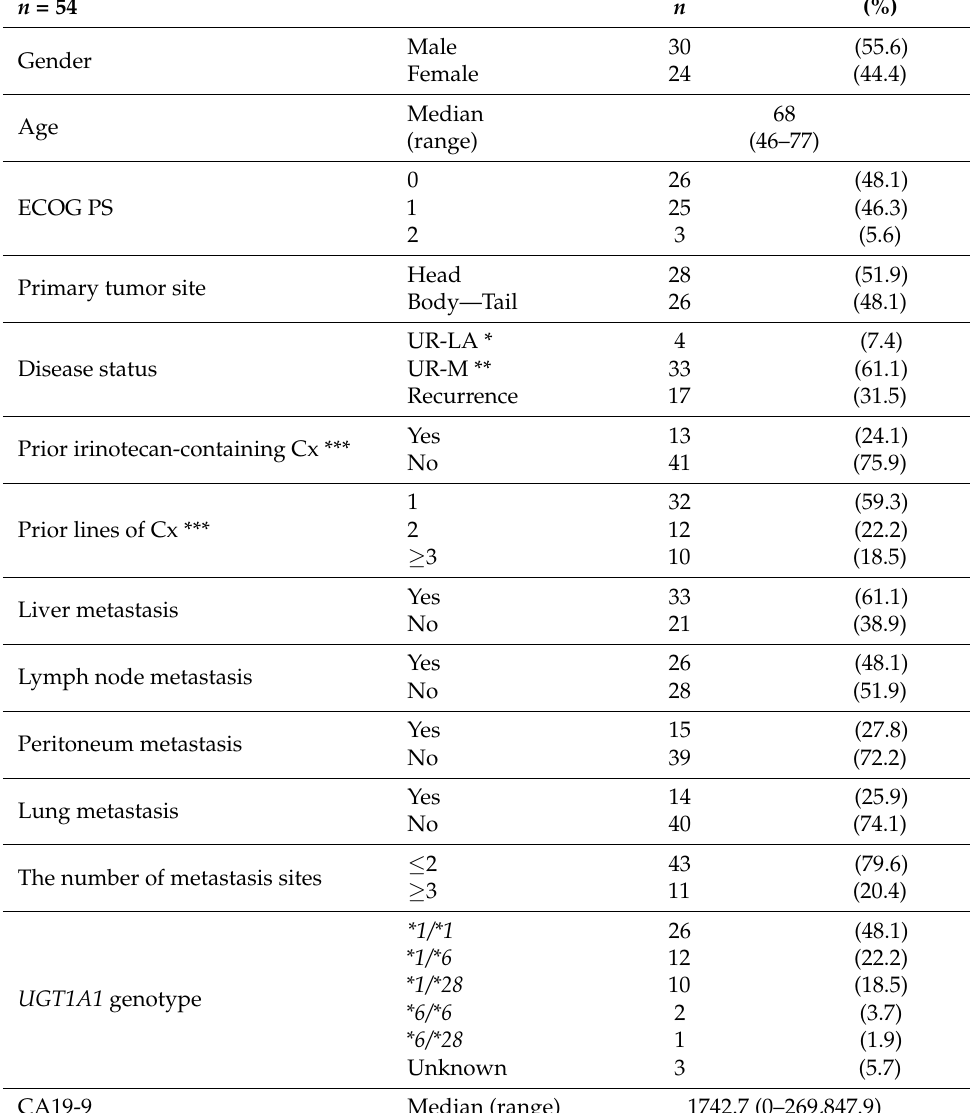
Table 1. Patient